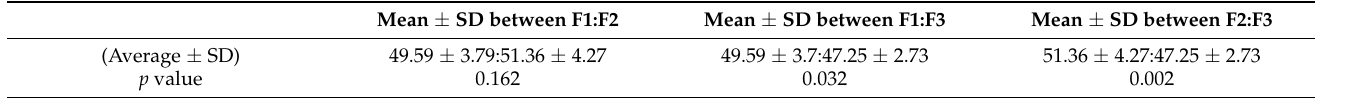
Table 5. Results of moisture difference comparison between products. Mean ± SD between